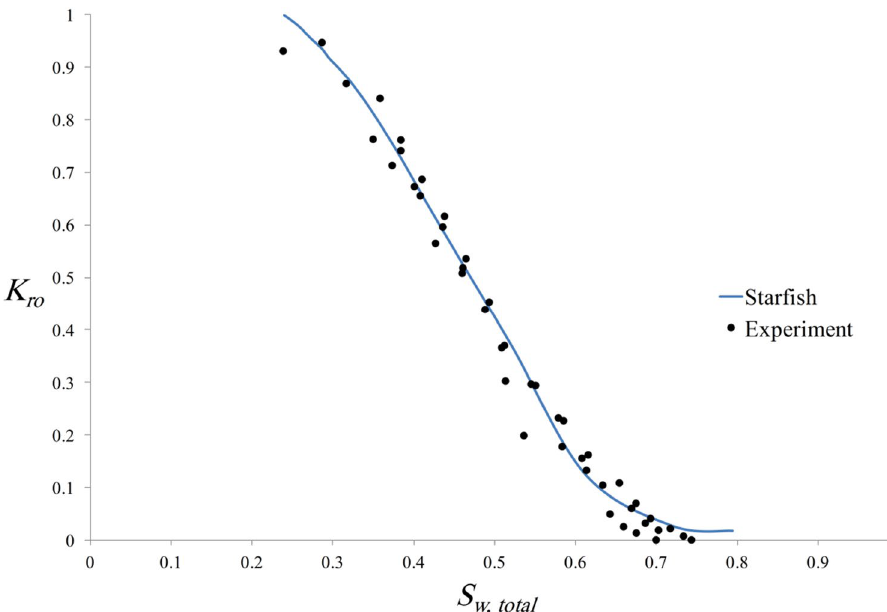
Fig. 5 Simulated and experi- mental oil relative permeability in imbibition